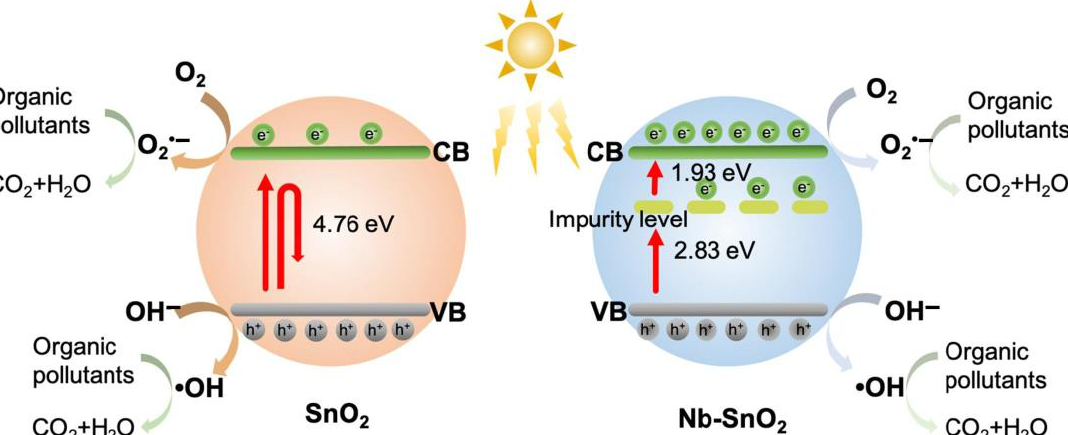
Figure 4. Photocatalytic mechanism of pure SnO 2 QDs and Nb-SnO 2 QDs [45], Copyright 2022, Elsevier.